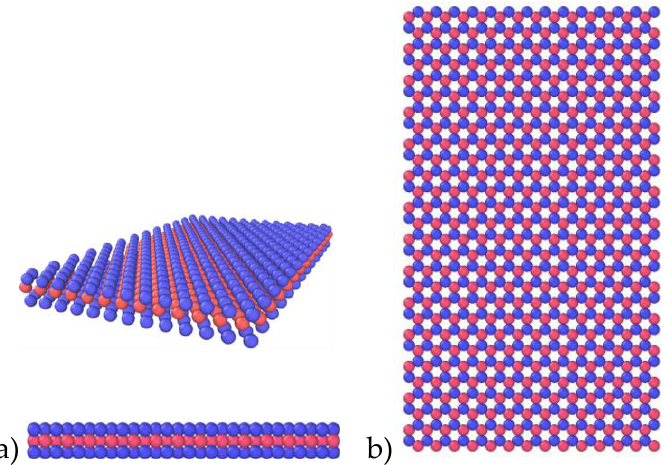
Figure 2. The atomistic model of monolayer MoS 2 without defects, blue balls represents Sulphur atoms top and bottom layers and red balls represent Molybdenum. The elastic constants for this pristine MoS 2 are C 11 = C 22 = 149.42 N / m, C 12 = 52.29 N / m. ( a ) Side and isometric view ( b ) top view.